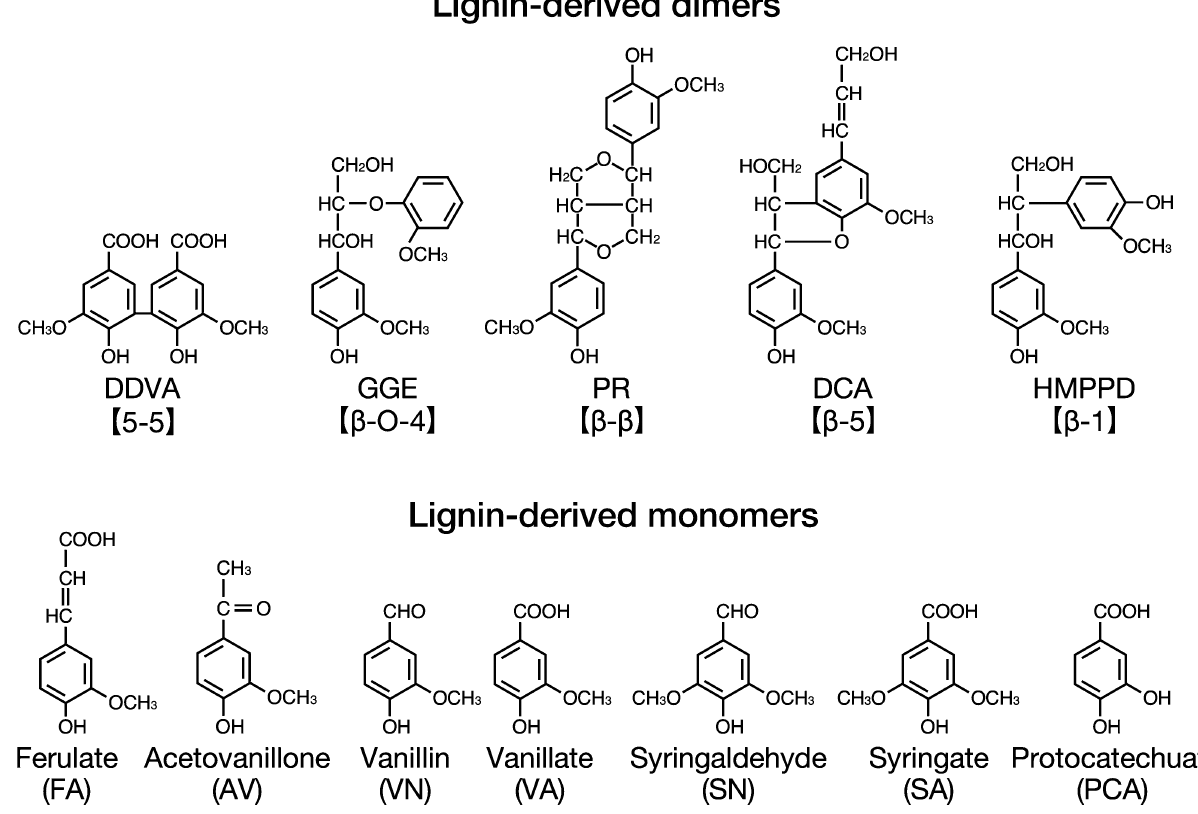
Figure 1. Chemical structures of lignin-derived dimers and monomers used in this study. DDVA, 5,5 ′ -dehydrodivanillate; GGE, guaiacylglycerol-β-guaiacyl ether; PR, pinoresinol; DCA, dehydrodiconiferyl alcohol; HMPPD, 1,2-bis(4-hydroxy-3-methoxyphenyl)-propane-1,3-diol. This figure was generated using Canvas X Draw version 7.0.2. (https:// www. canva sgfx. com/ produ cts/ canvas- x- draw).